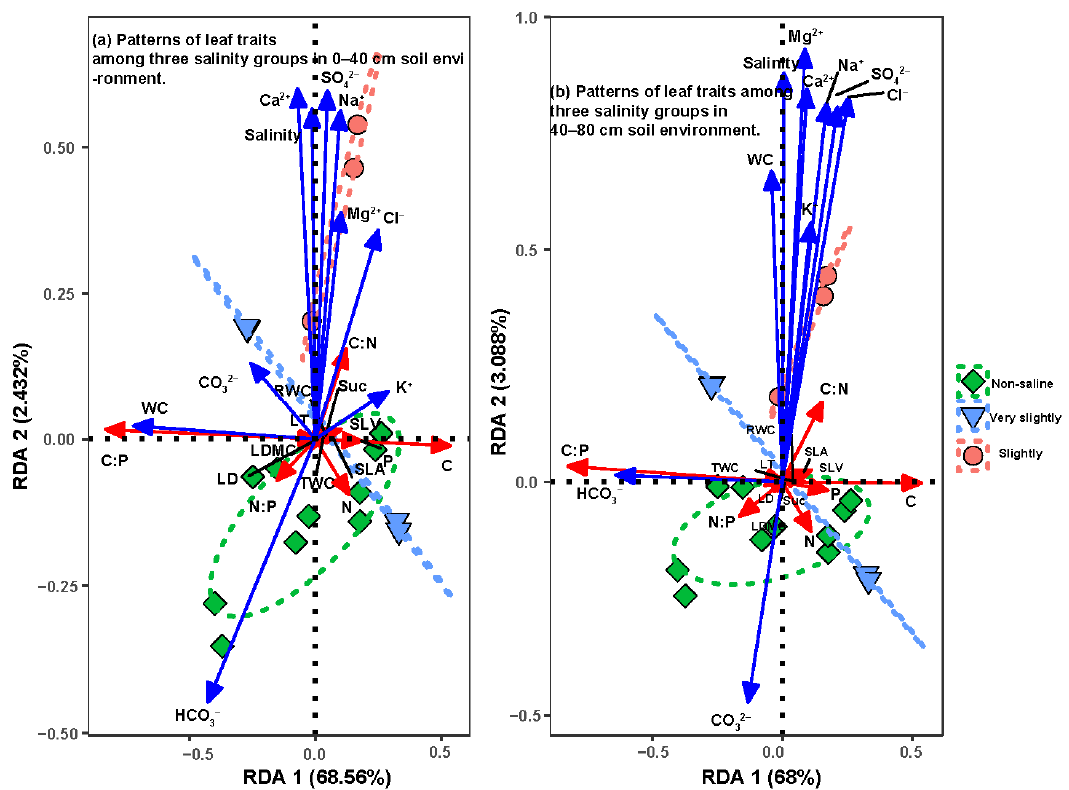
Figure 3. RDA of leaf functional traits and environmental variables of Lycium ruthenicum populations in the lower reaches of the Heihe River. The red arrows are the leaf functional traits data; the blue arrows represent the soil traits that were included in the models as the underlying environmental factors. The direction of the arrow indicating a positive or negative correlation among the environmental factors with the ordination axes. The angle of the arrow reflects the strength of correlation between the environmental factors and leaf functional traits, with small angles indicating strong correlations. Environmental variables include water (WC, 0–40 and 40–80 cm soil), salinity (0–40 and 40–80 cm soil) and soil ions (Na + , K + , Ca 2+ , Mg 2+ , CO 32− , HCO 3− , SO 42− , Cl − ). The dotted green circle represents the non-salt group, the blue circle represents the very slightly salt group and the red circle represents the slightly salt group.